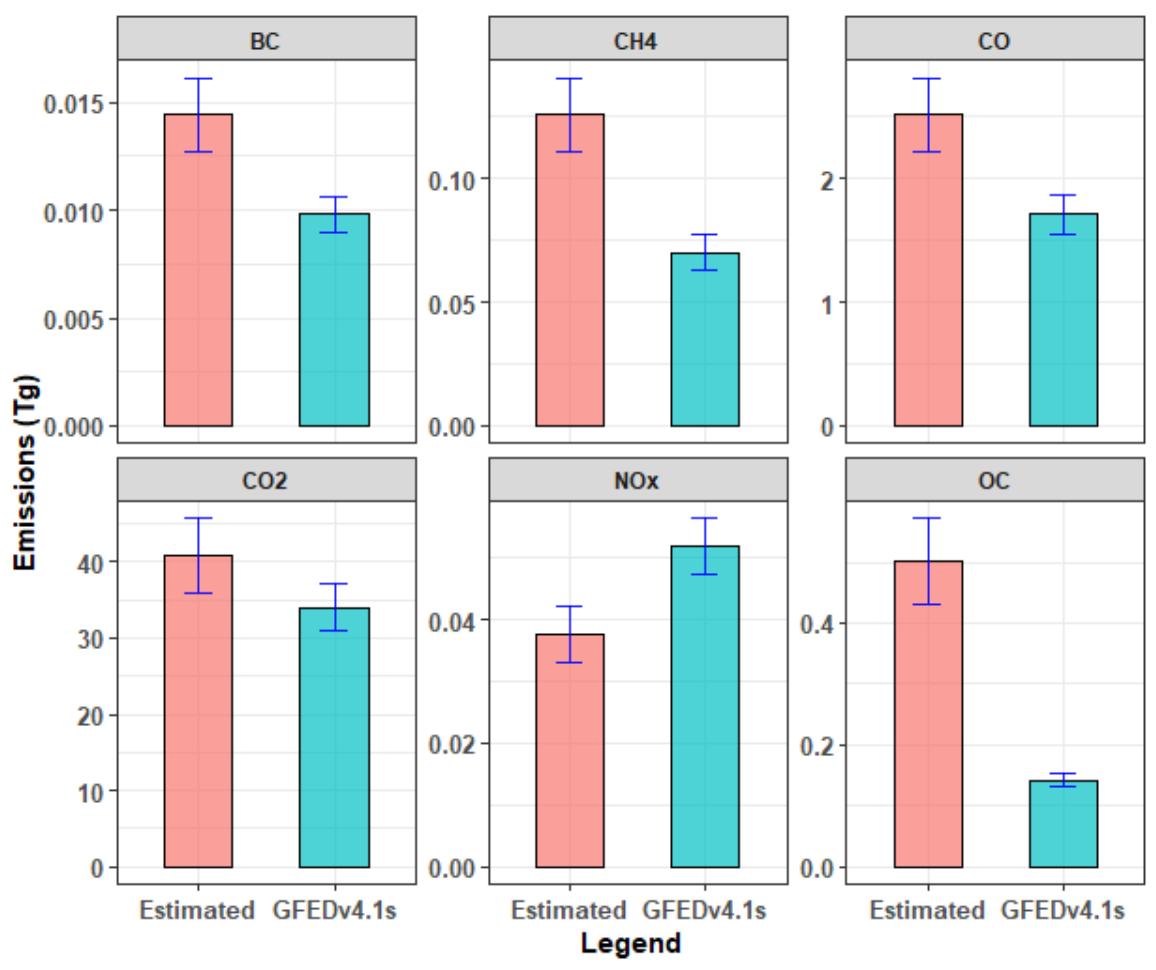
Figure 7. Comparison of annual averaged (2001 – 2020) emissions from Global Fire Emissions data version 4.1s (GFED v4.1s) with the pixel-based computed emissions of this study (Estimated). The error bar is based on the standard error of annual emissions. Table 5. The statistical association between the estimated emissions from forest fire and the GFED4.1s-derived emissions (in Tg).